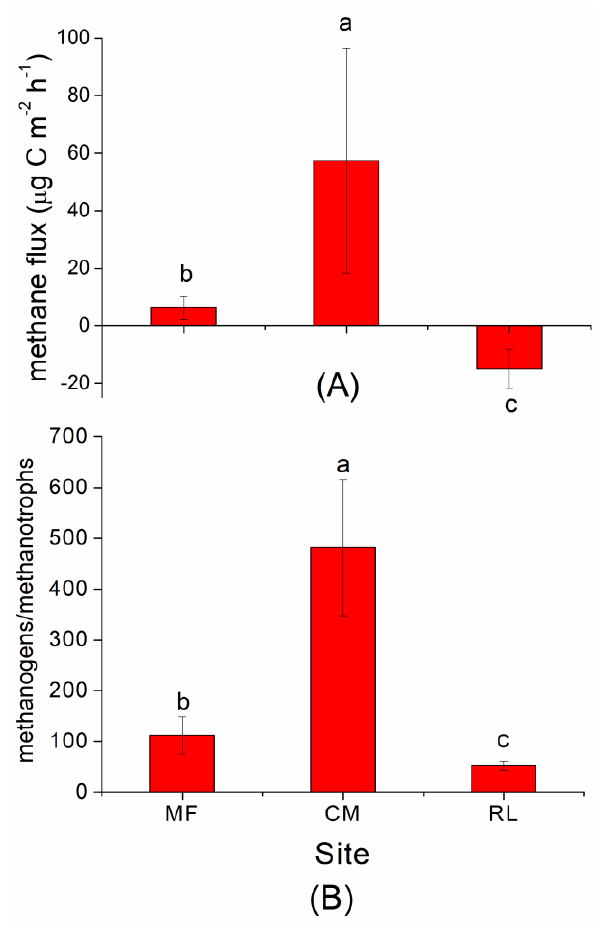
Figure 2. Average methane flux ( A ) and the abundance ratio of methanogens and methanotrophs ( B ) from 5 November to 6 December 2016, at three sites in the Dongting floodplain. The data used in ( B ) is the average ratio of methanogens and methanotrophs gene abundance across the 0–30 cm soil profile. Site abbreviations: MF: mudflat, CM: Carex meadow, RL: reed land. Different lowercase letters in the same column within each sampling site indicate significant differences ( p < 0.05) among the three soil layers.